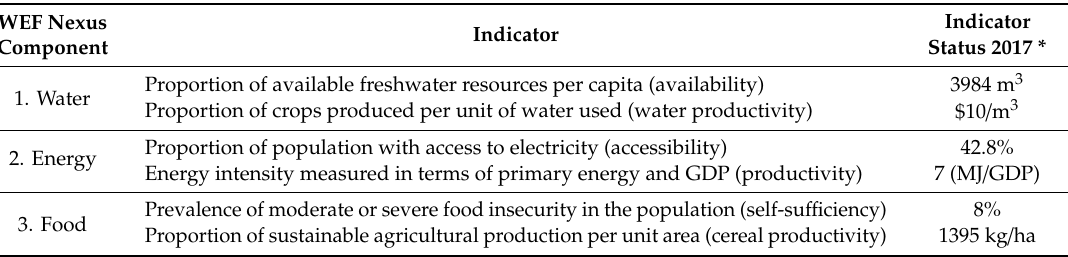
Table 2. Overview of the WEF nexus indicators for southern